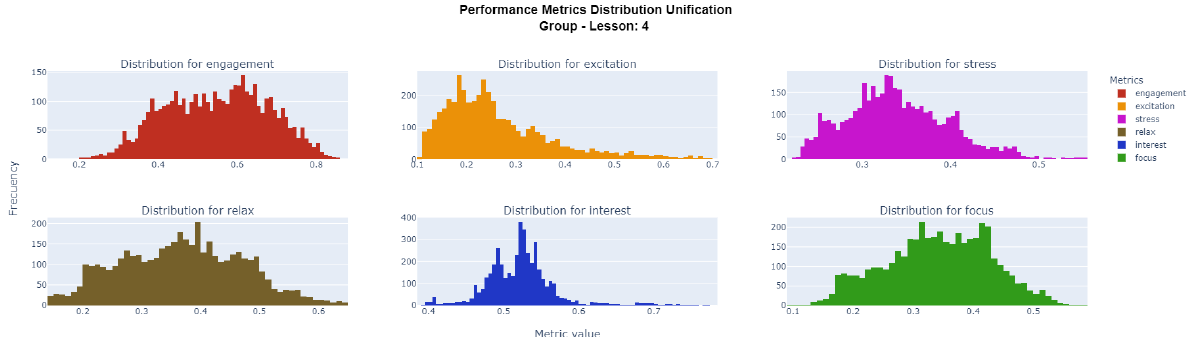
Figure 10. Unified distribution of emotional metrics group and lesson.